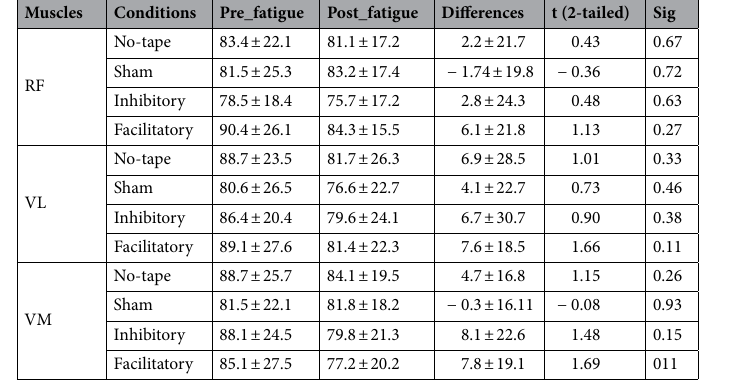
Table 1. RF, VL, and VM activity (RMS in %MVC) in four different conditions (no-tape, sham, inhibitory and facilitatory KT conditions). VM Vastus Medialis, RF Rectus Femoris, VL Vastus Lateralis.